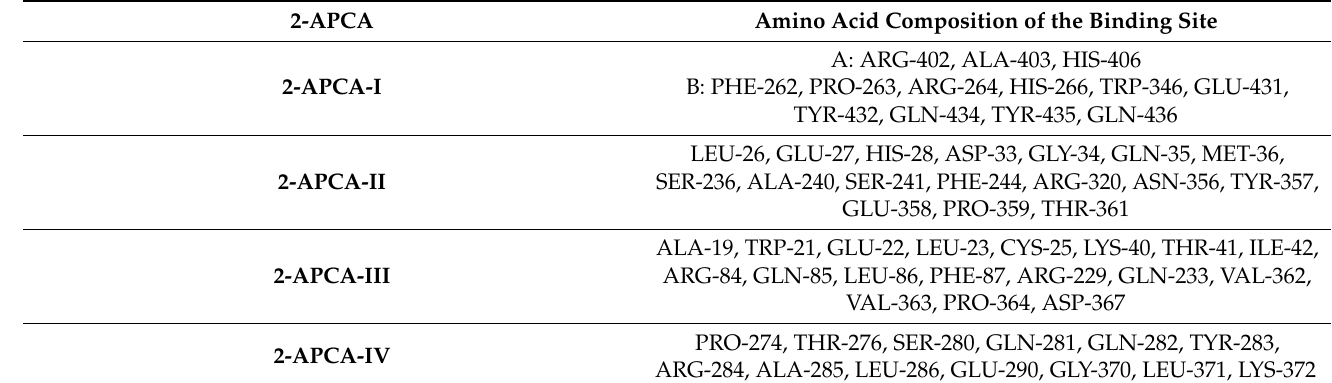
Figure 10. The molecular docking results and binding sites of 2- АРСА -I ( A , B ), 2- АРСА -II ( C , D ), 2- АРСА -III ( E , F ), and 2- АРСА -IV ( G , H ) in tubulin. Table 4. The amino acid composition of the 2-APCAs binding sites in